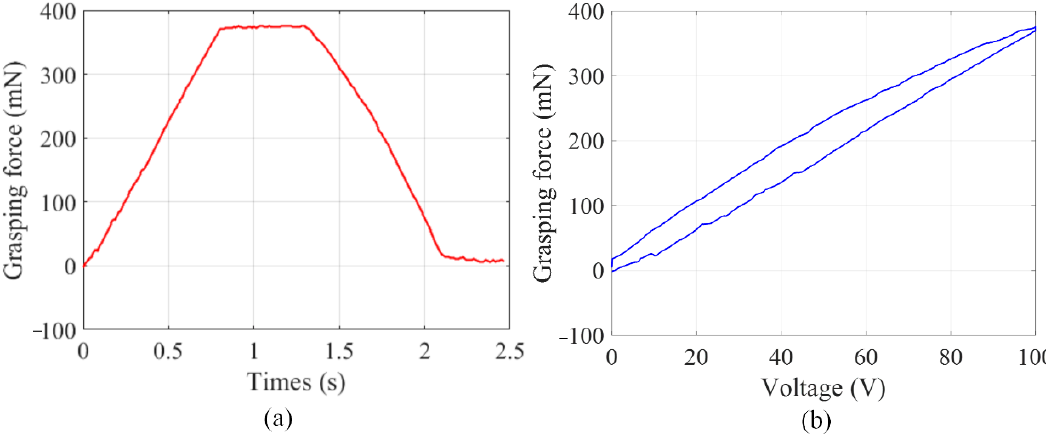
Figure 7. The grasping force test, ( a ) trapezoid response, ( b ) hysteresis nonlinearity.